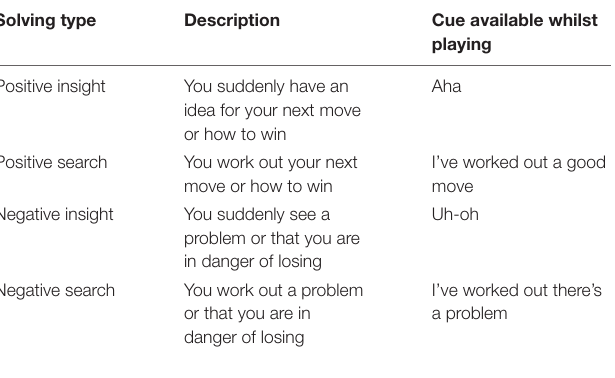
TABLE 1 | Self-reported feeling of insight: descriptions given to participants playing Connect